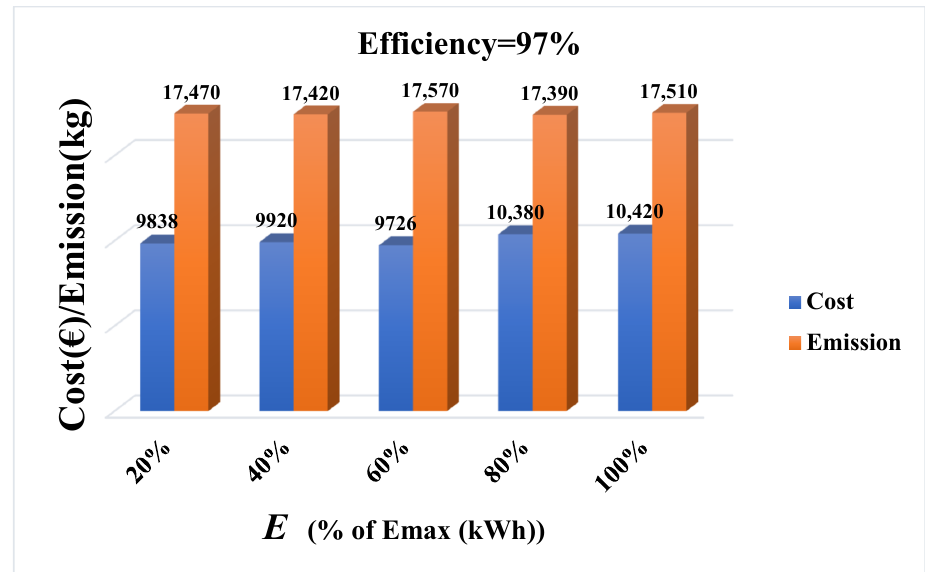
Figure 9. Cost and emission of the BCS in different initial charge values for 97% efficiency.